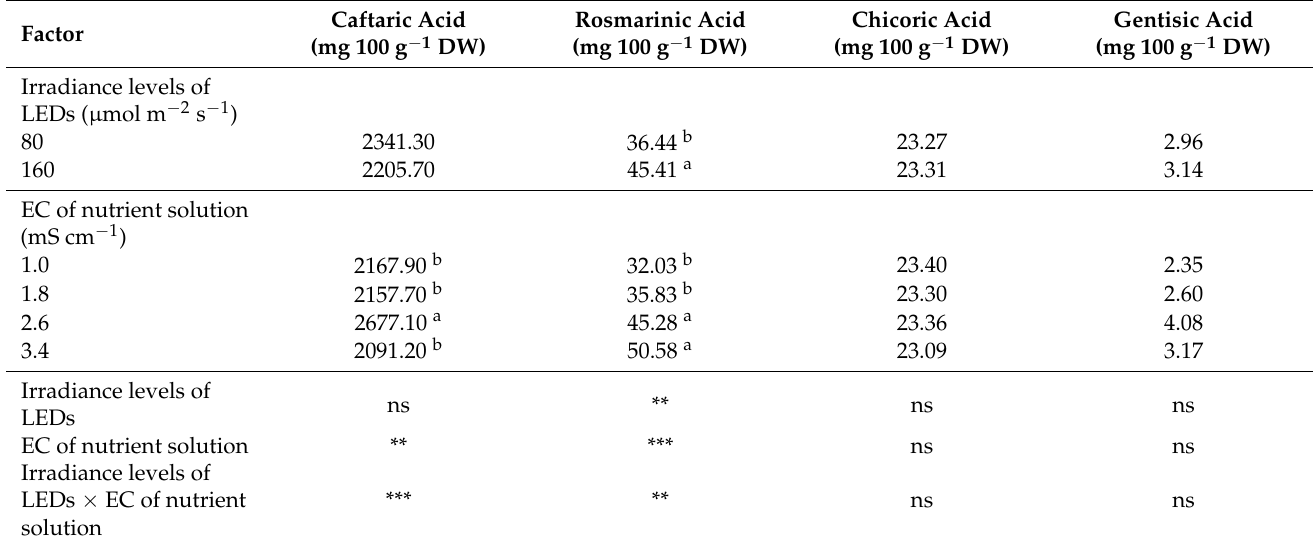
Table 6. Effects of LED irradiance levels and nutrient solution EC on the concentration of the individual phenolic compounds of lemon basil.